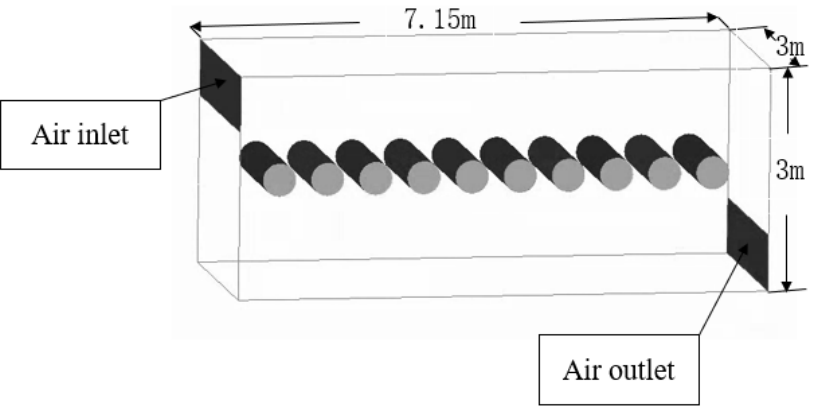
Figure 1. Computational fluid dynamics geometric model. The distance between the sows is 0.65 m. The length and width of the air inlet and air outlet are both 3 × 0.75 m.